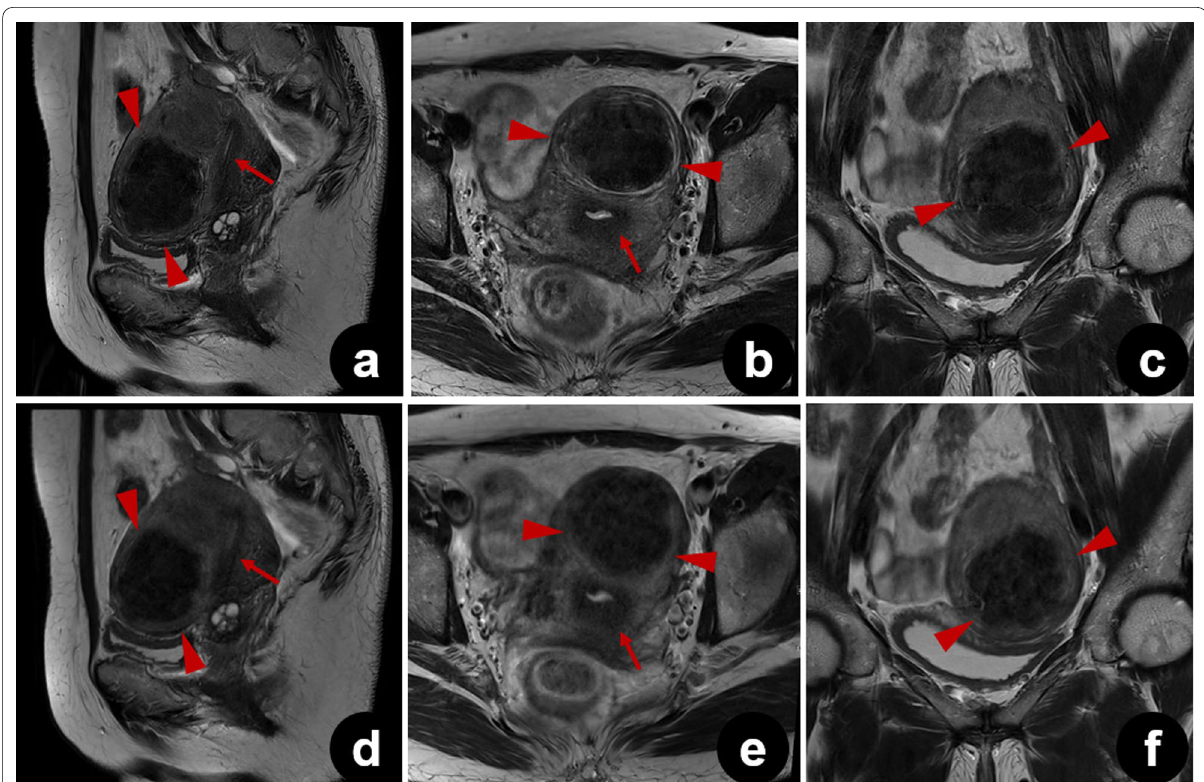
Fig. 5 Pelvic T2 DL and T2 S images of a 47‑year‑old female patient with leiomyoma. a – f Sagittal ( a ), axial ( b ), and coronal ( c ) T2 DL images and sagittal ( d ), axial ( e ), and coronal ( f ) T2 S images. The edge and internal structure of the tumor were most clearly delineated by T2 DL (between arrowheads). Note that sharper uterine zonal layers are also observed on T2 DL images (arrows). T2 DL deep learning - accelerated T2‑weighted turbo spin echo sequence; T2 S standard T2‑weighted turbo spin echo